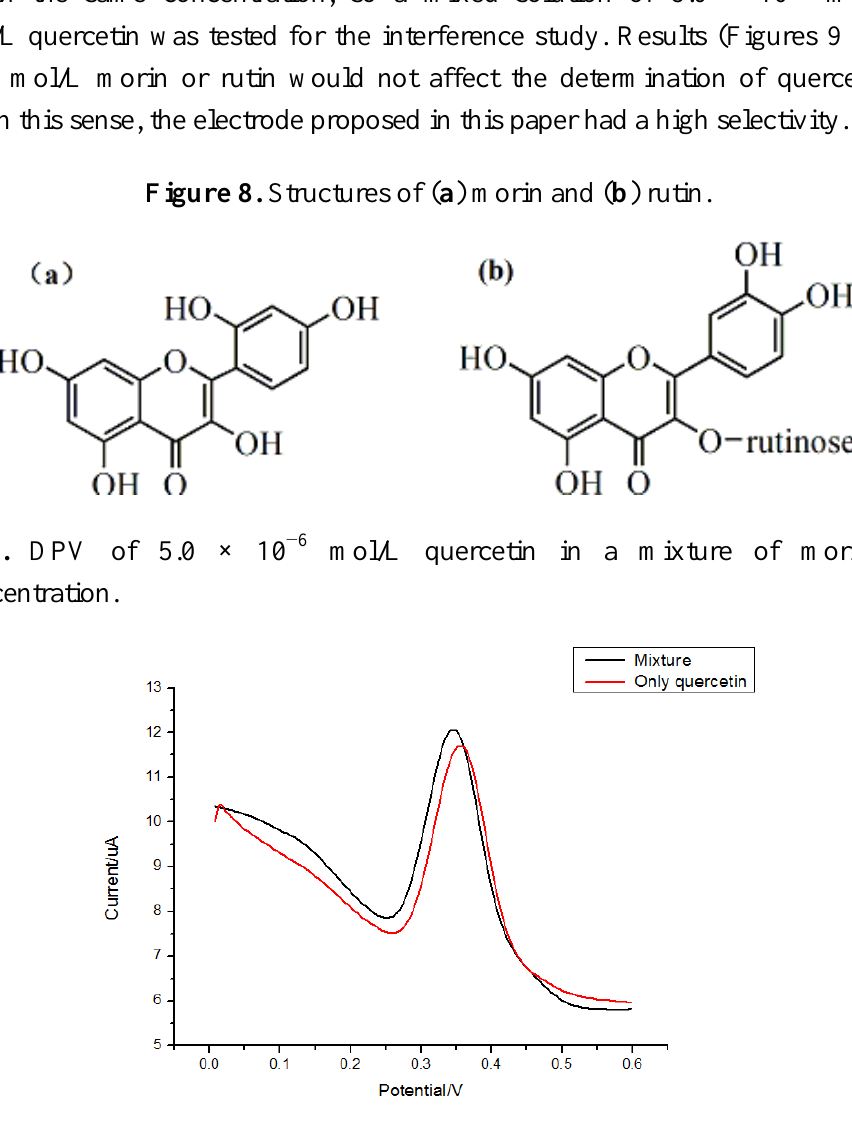
Figure 10. DPV of 5.0 × 10 −6 mol/L quercetin in a mixture of rutin with the same